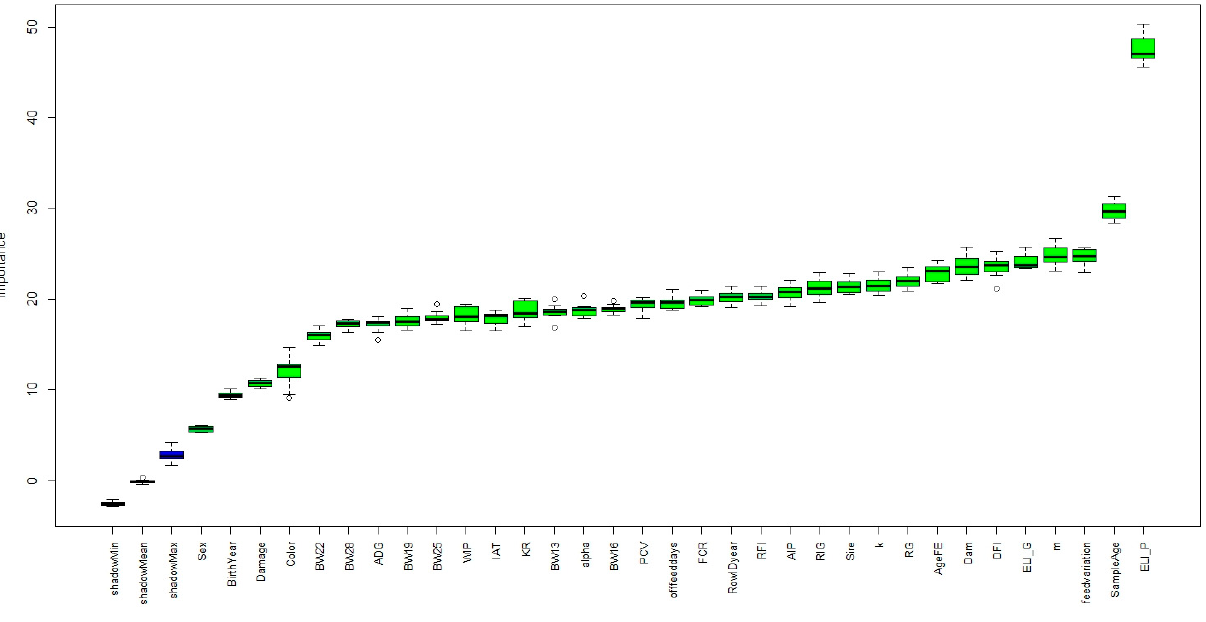
Figure 2. Feature importance based on the Boruta package. Blue boxplots correspond to the minimal, average, and maximum Z scores of a shadow attribute. Green boxplots represent the Z scores of the confirmed attributes. ° in the plot indicated the outliners.